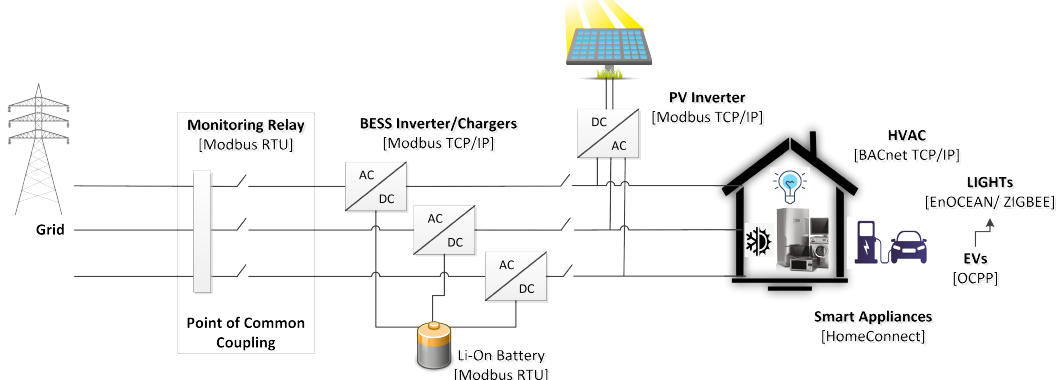
Figure 4. MG High Level Electrical Design.